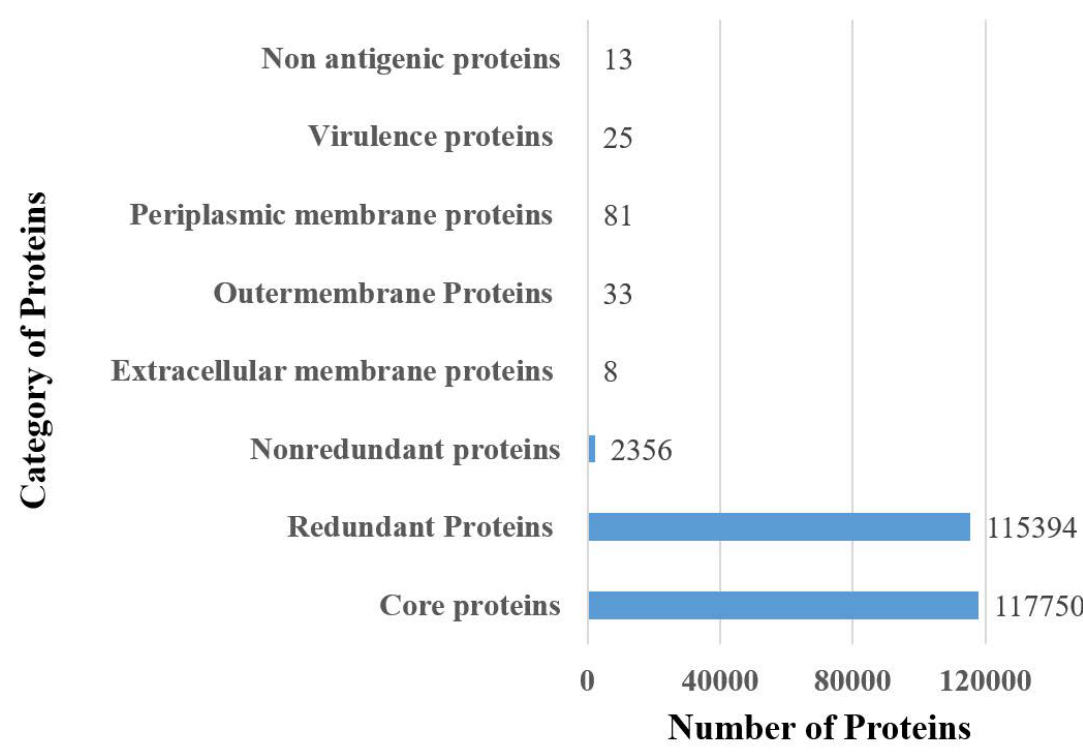
Figure 2. Number of proteins obtained at each step of subtractive proteomics.